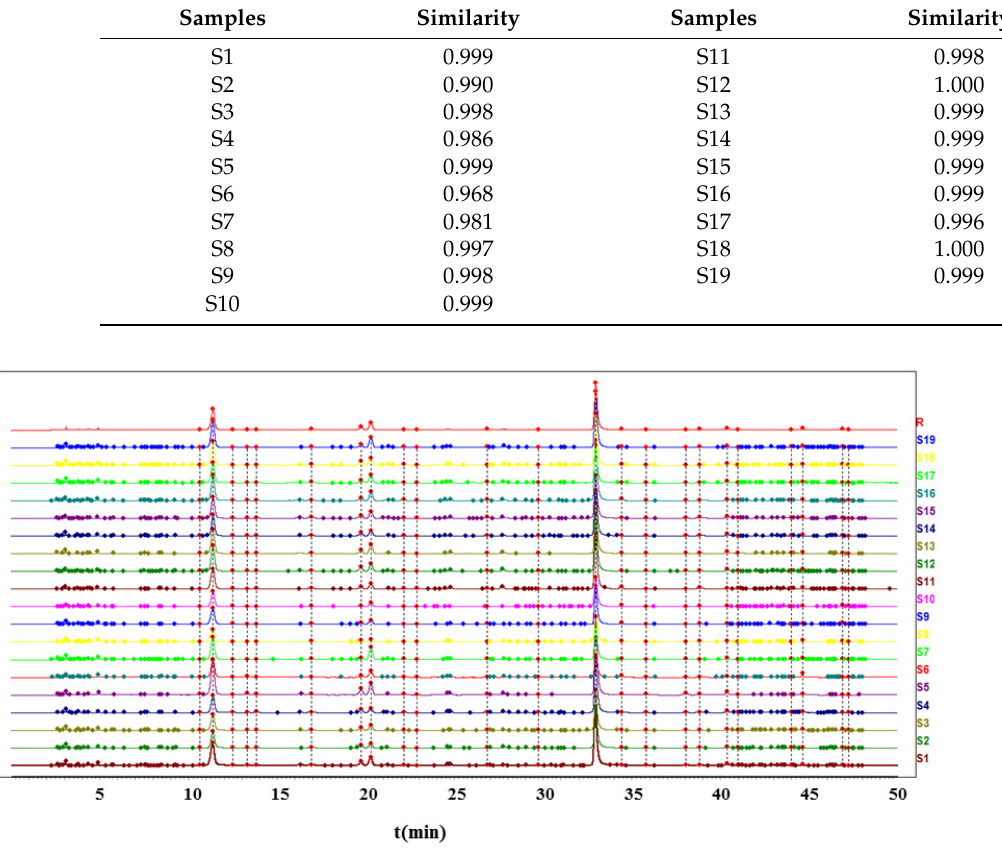
Figure 1. Typical LC chromatograms of sample solution. Table 1. Similarity analysis results of 19 batches of dandelion.